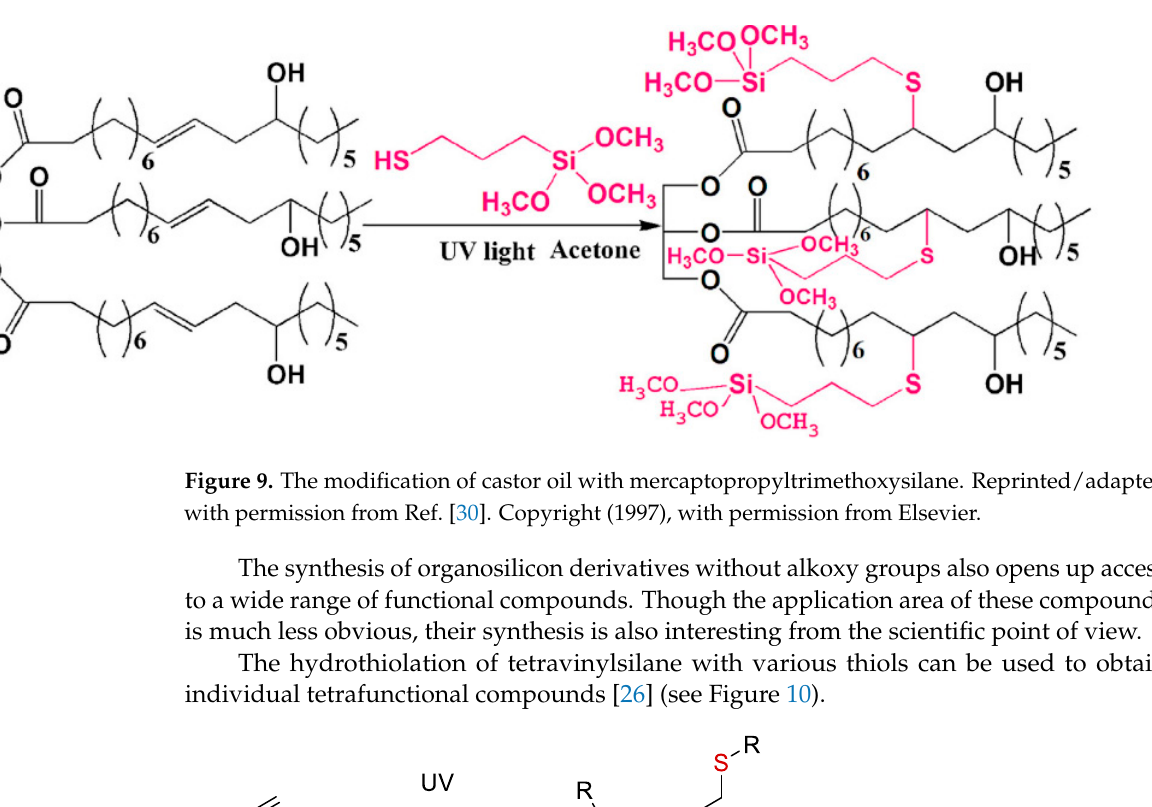
Figure 9. The modification of castor oil with mercaptopropyltrimethoxysilane. Reprinted/adapted with permission from Ref. [30].